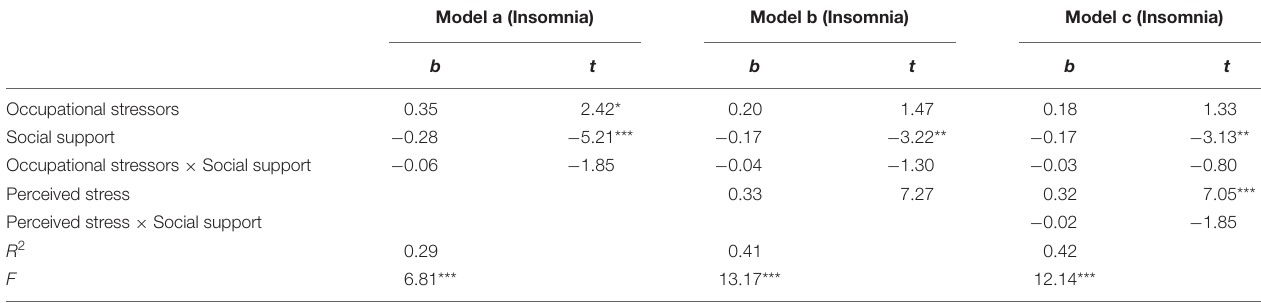
TABLE 6 | Testing the moderated mediation effect in the model of